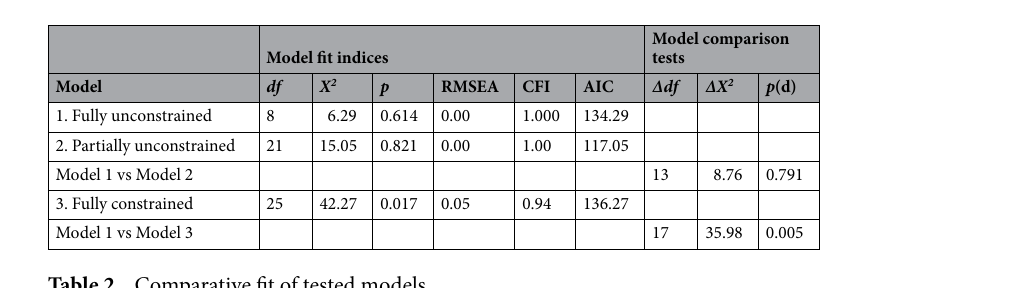
Figure 2. Final structural equation model for olderadults.